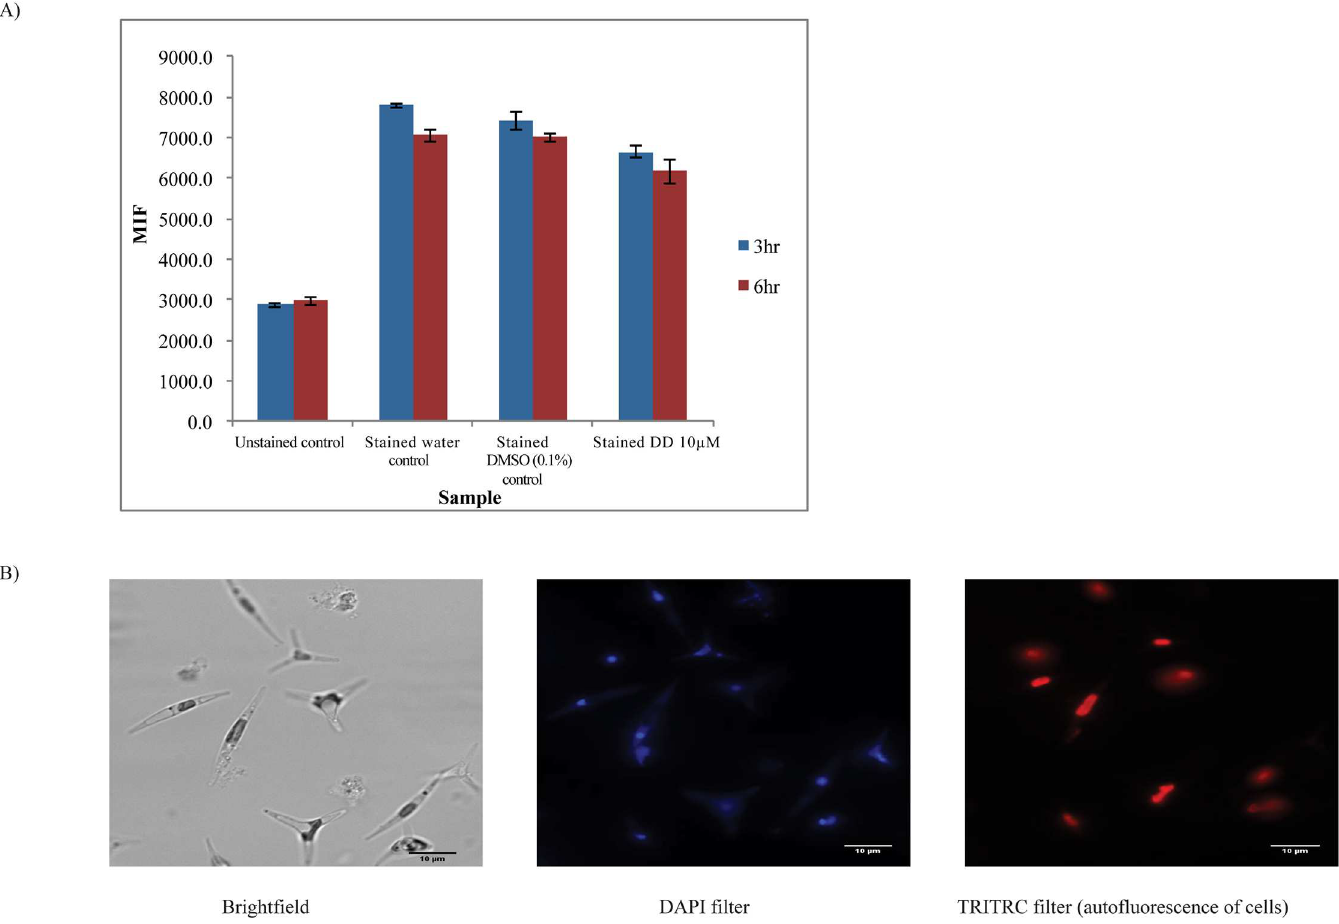
Fig 6. Effects of DD on Hoechst 33342 staining. A) Analysis of fluorescence of stainedcells by flow cytometer (BDFACS Aria) using Hoechst 33342 stain B) Bright field image, fluorescence image under DAPI (blue) of stained cells; Autofluorescenceof cells (Red) under TRITC filter at 630X magnification (scale bar = 10 µ m). p < 0.05 calculatedusing student’s t-test; n = 3 comparedto solvent control. Data are representative of 3 independent